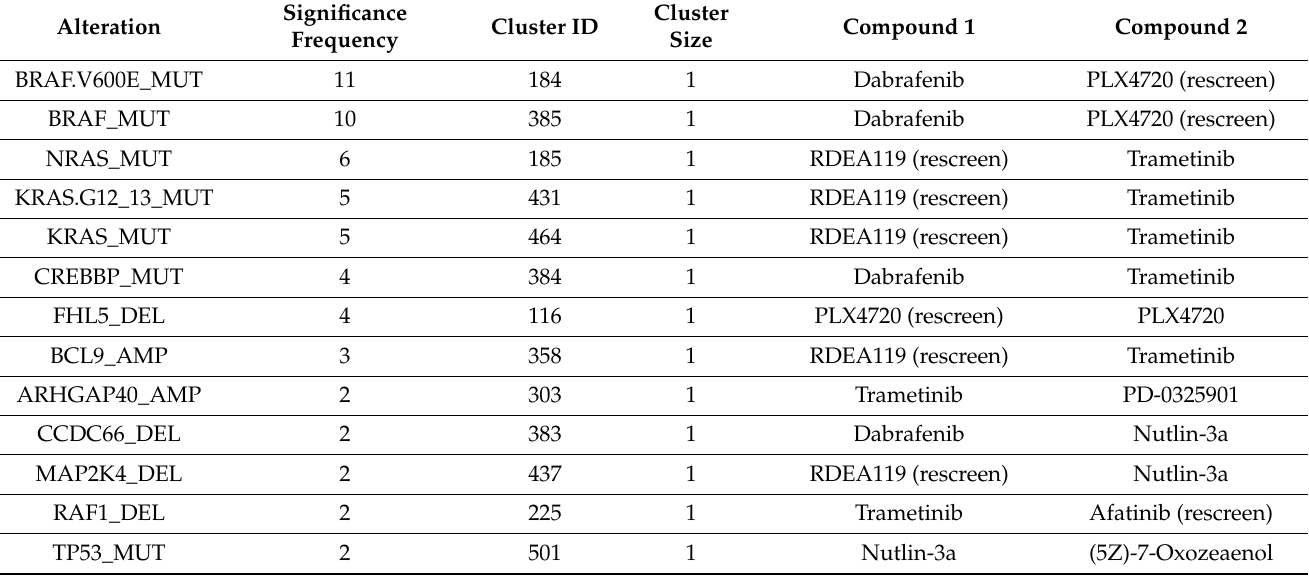
Table 3 shows Report 2 up to alterations significantly influential ( p < 0.005) for >1 com- pounds; Supplementary Table S2 shows the whole of Report 2. BRAF.V600E_MUT and BRAF_MUT alterations were significantly influential for the largest number of compounds in Report 1 (11 and 10, respectively). Table 3. Report 2 up to alterations significantly influential ( p < 0.005) for >1 compounds in Report 1 (in decreasing order of